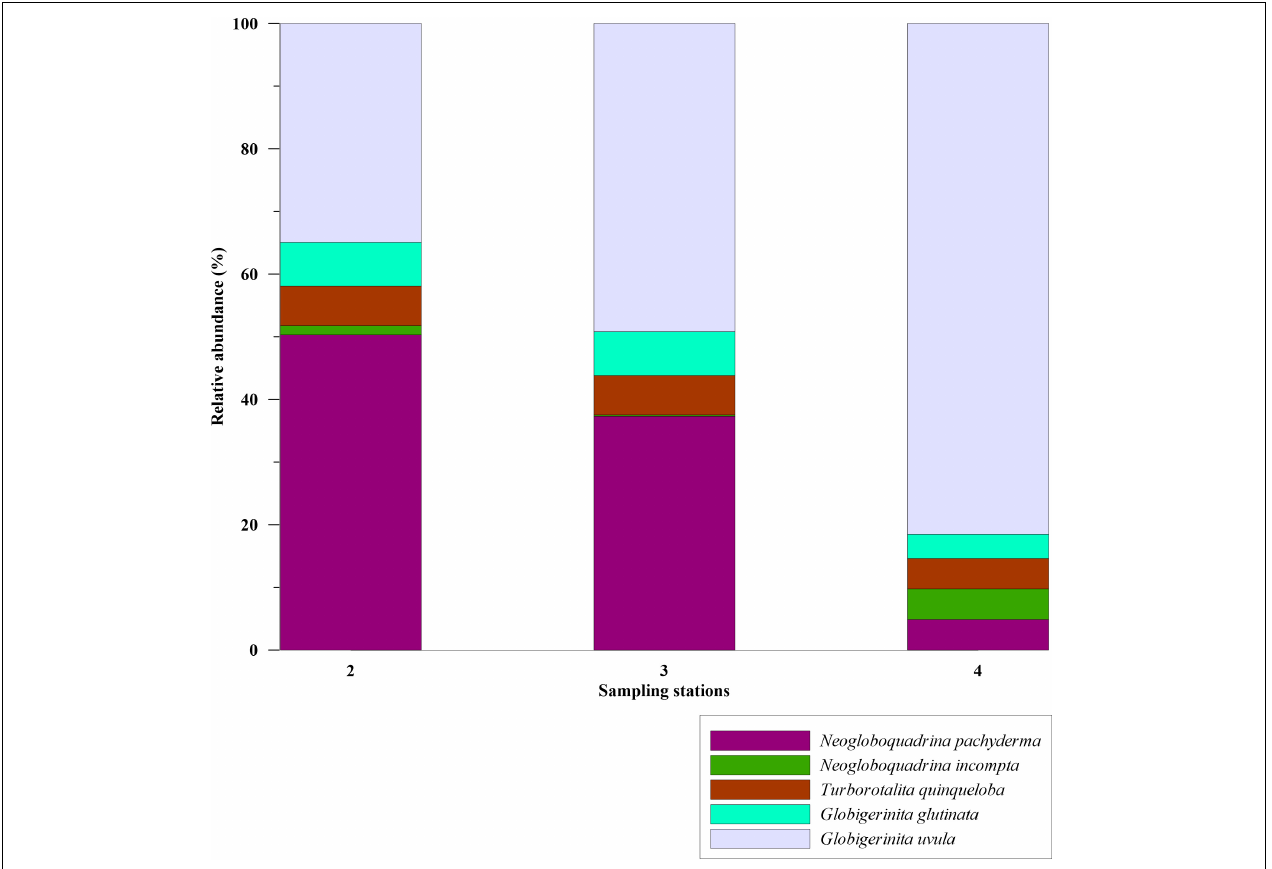
FIGURE 8 | Relative abundance (%) of planktic foraminiferal species in 63–100 µ m size fraction from the stations of Labrador Sea, shown in bar